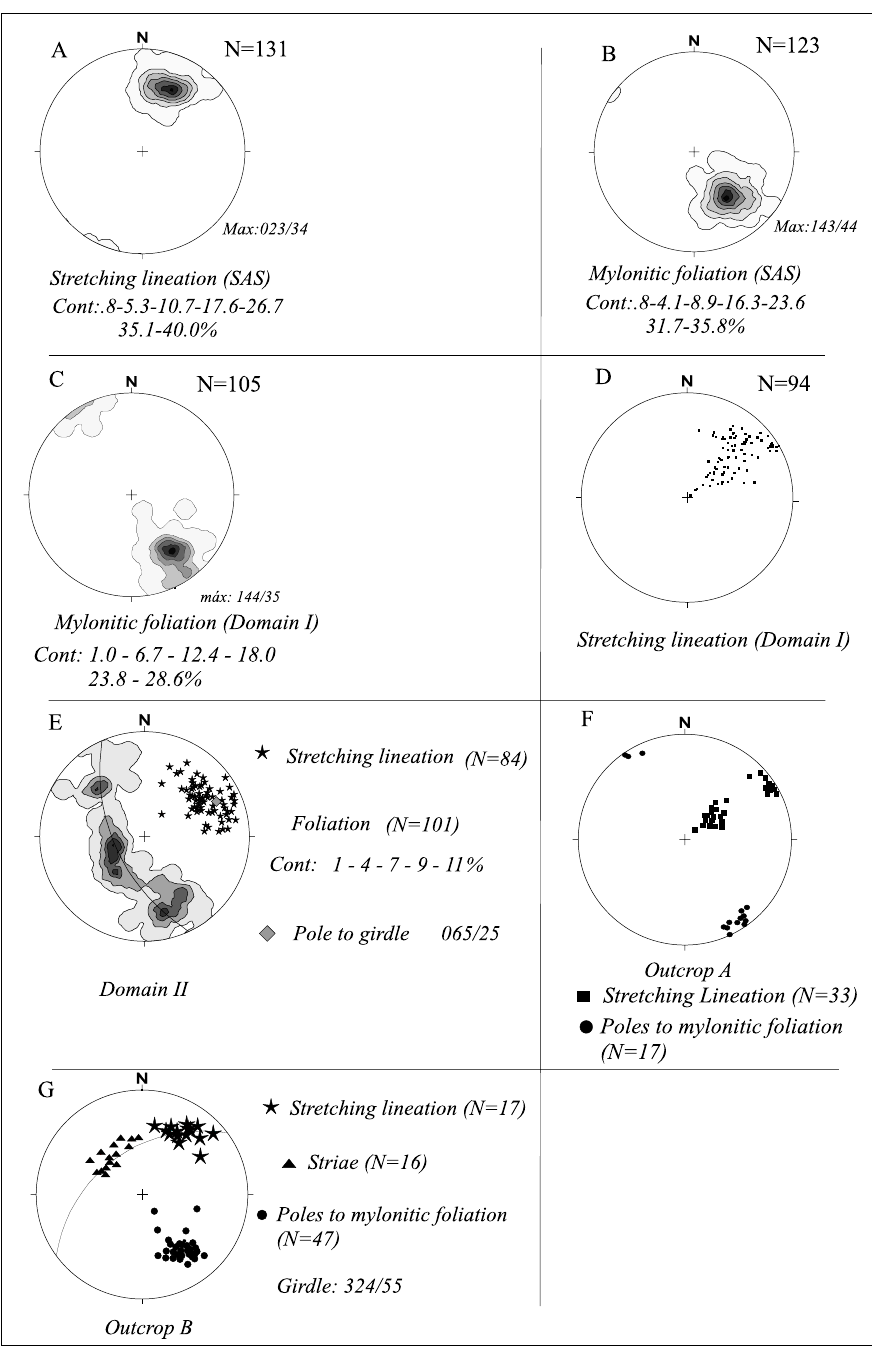
Fig. 3 – Stereographic plots (lower hemisphere projections) of the structural elements measured in the cross-sections. 3a and 3b – foliation and lineation of the SAS; 3c and 3d – foliation and lineation in Structural domain I of the ATS; 3e – Structural domain II of the ATS; 3f – outcrop of a high-grade shear zone with two mineral lineations (Dom I of the ATS); 3g – outcrop of RSSZ. See text for further explanation and